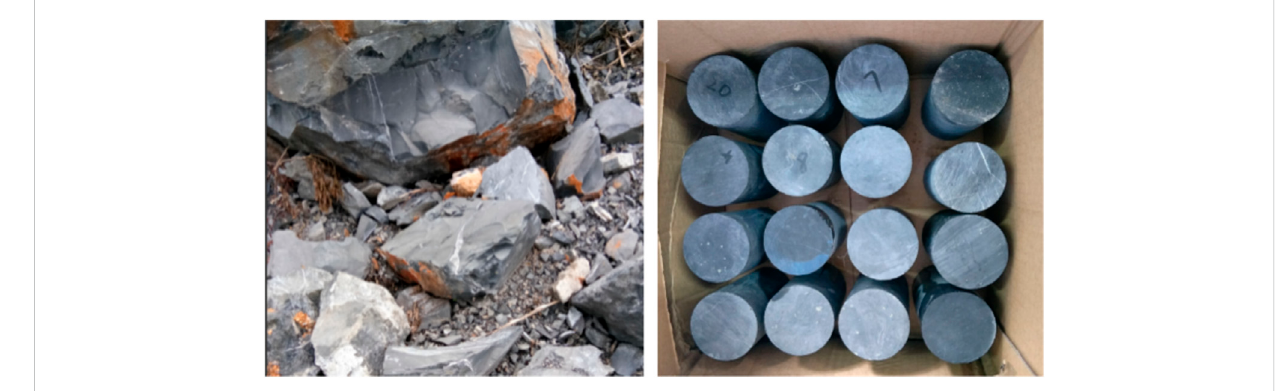
FIGURE 2 Complete rock and prepared standard rock specimens.